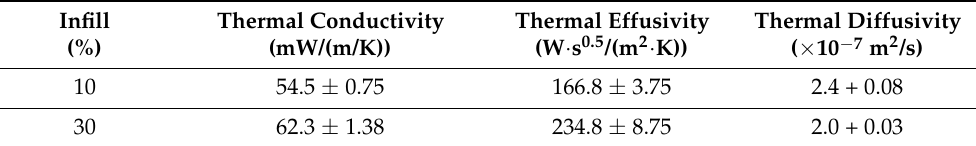
Table 4. Thermal properties of 3D printed PC as a function of the in ‐ fill ratio. The printing temper ‐ ature is 280 °C.